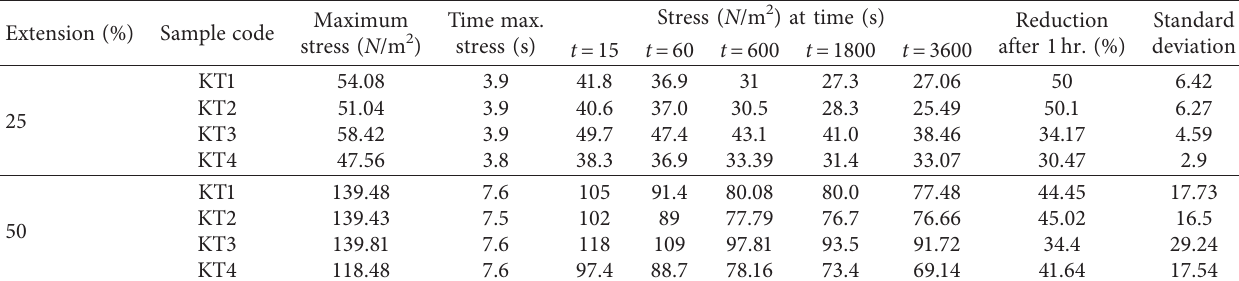
Table 4: Observations of the stress relaxation experiment in the warp